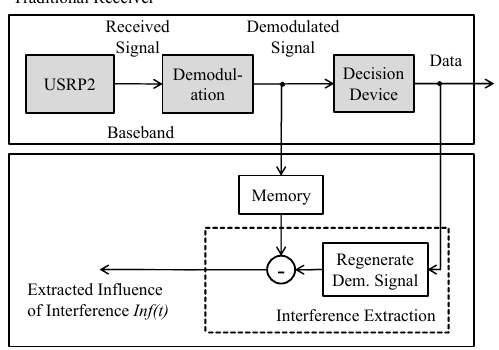
Figure 7. Interference extraction with OQPSK interference for 64 demodulated bits